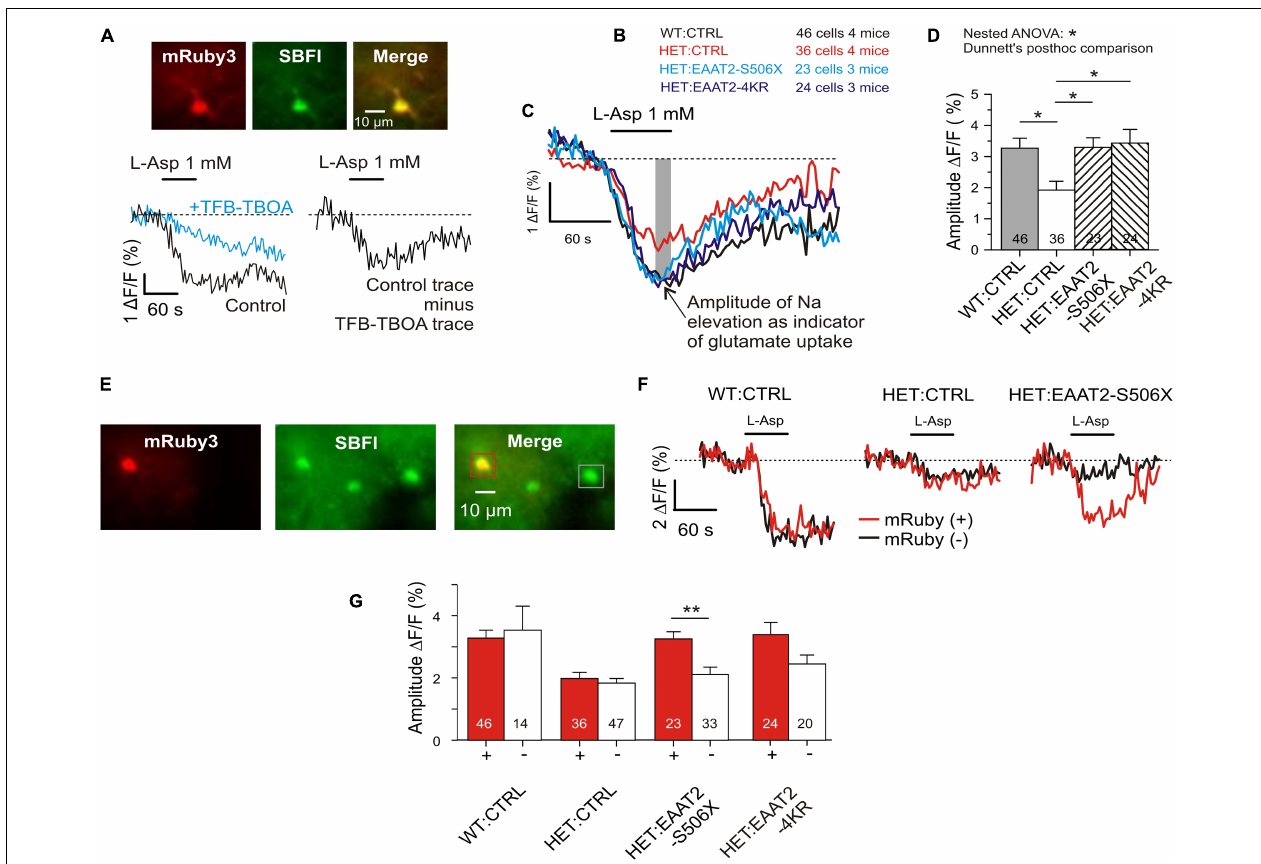
FIGURE 5 | Recovery of glutamate uptake in striatal astrocytes. (A) Measurement of glutamate uptake by sodium imaging with SBFI, in the presence of CBX (100 µ M), DNQX (10 µ M), and MK801 (1 µ M). Traces recorded in the absence and presence of TFB-TBOA (2 µ M). The amplitude of this differential response was expressed as (cid:49) F / F during the last 15 s of L -Asp application. F is the mean fluorescence at rest, before drug application. (B) Tested animal groups. (C) Averaged traces of SBFI fluorescence. Results from mRuby-positive astrocytes only. (D) Quantification of the L -aspartate-induced sodium elevation. Two-level (“nested”) statistics (animal level, cell level, and post hoc comparison between groups). (E) The applied SBFI loading protocol was selective for astrocytes. View field with 3 astrocytes, where one is transduced and two are not. (F) Traces from mRuby+ as opposed to mRuby– in three test groups. Averaged traces from one animal per group. (G) Comparison of results obtained in the different groups from mRuby+ vs. mRuby– astrocytes. * p < 0.05, ** p < 0.01.